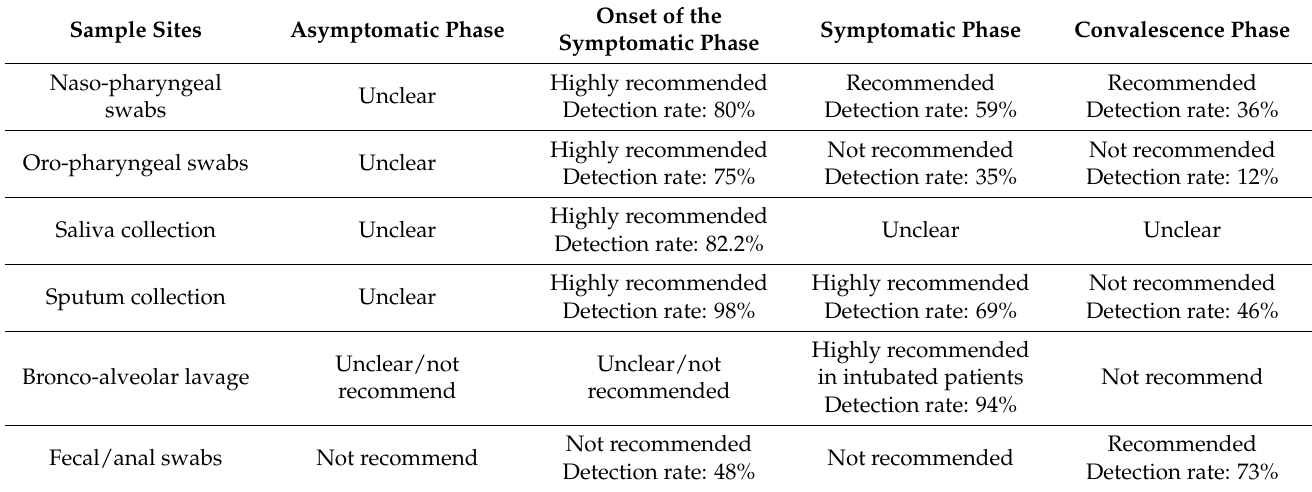
Table 3. COVID-19 disease phase and sample site